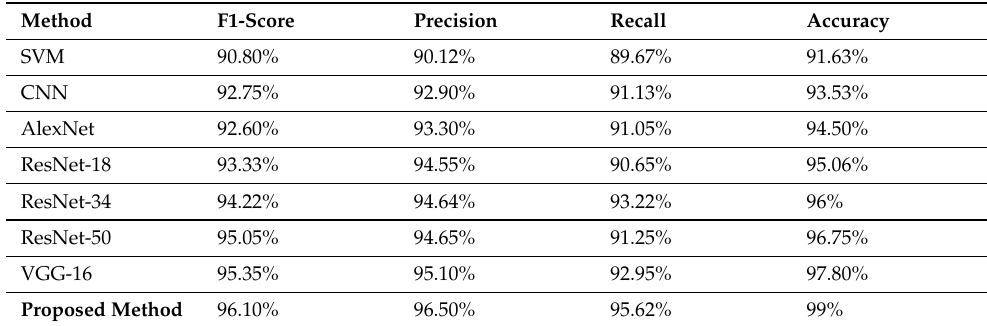
Table 4. Performance measure for various techniques for brain-tumor